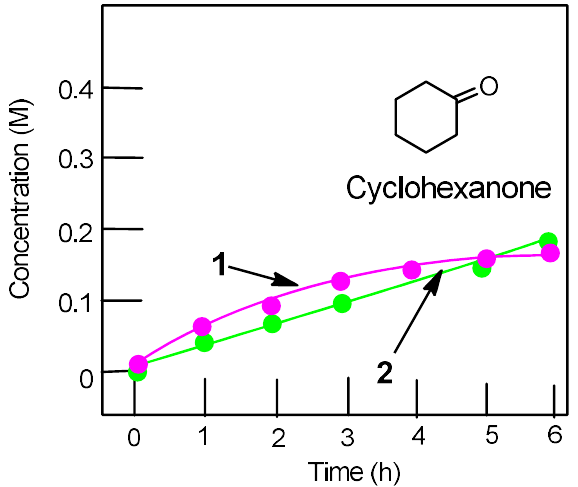
Figure 10. Oxidation of cyclohexanol with tert -butyl hydroperoxide catalyzed by complex 1 (Curve 1) and by complex 3 (Curve 2). Conditions: cyclohexanol (0.5 M), tert -butyl hydroperoxide (1.5 M, aqueous 70%), acetonitrile up to 5 mL, catalyst (5 × 10 −4 M), 50° C. Reaction quenched by the addition of PPh 3 .